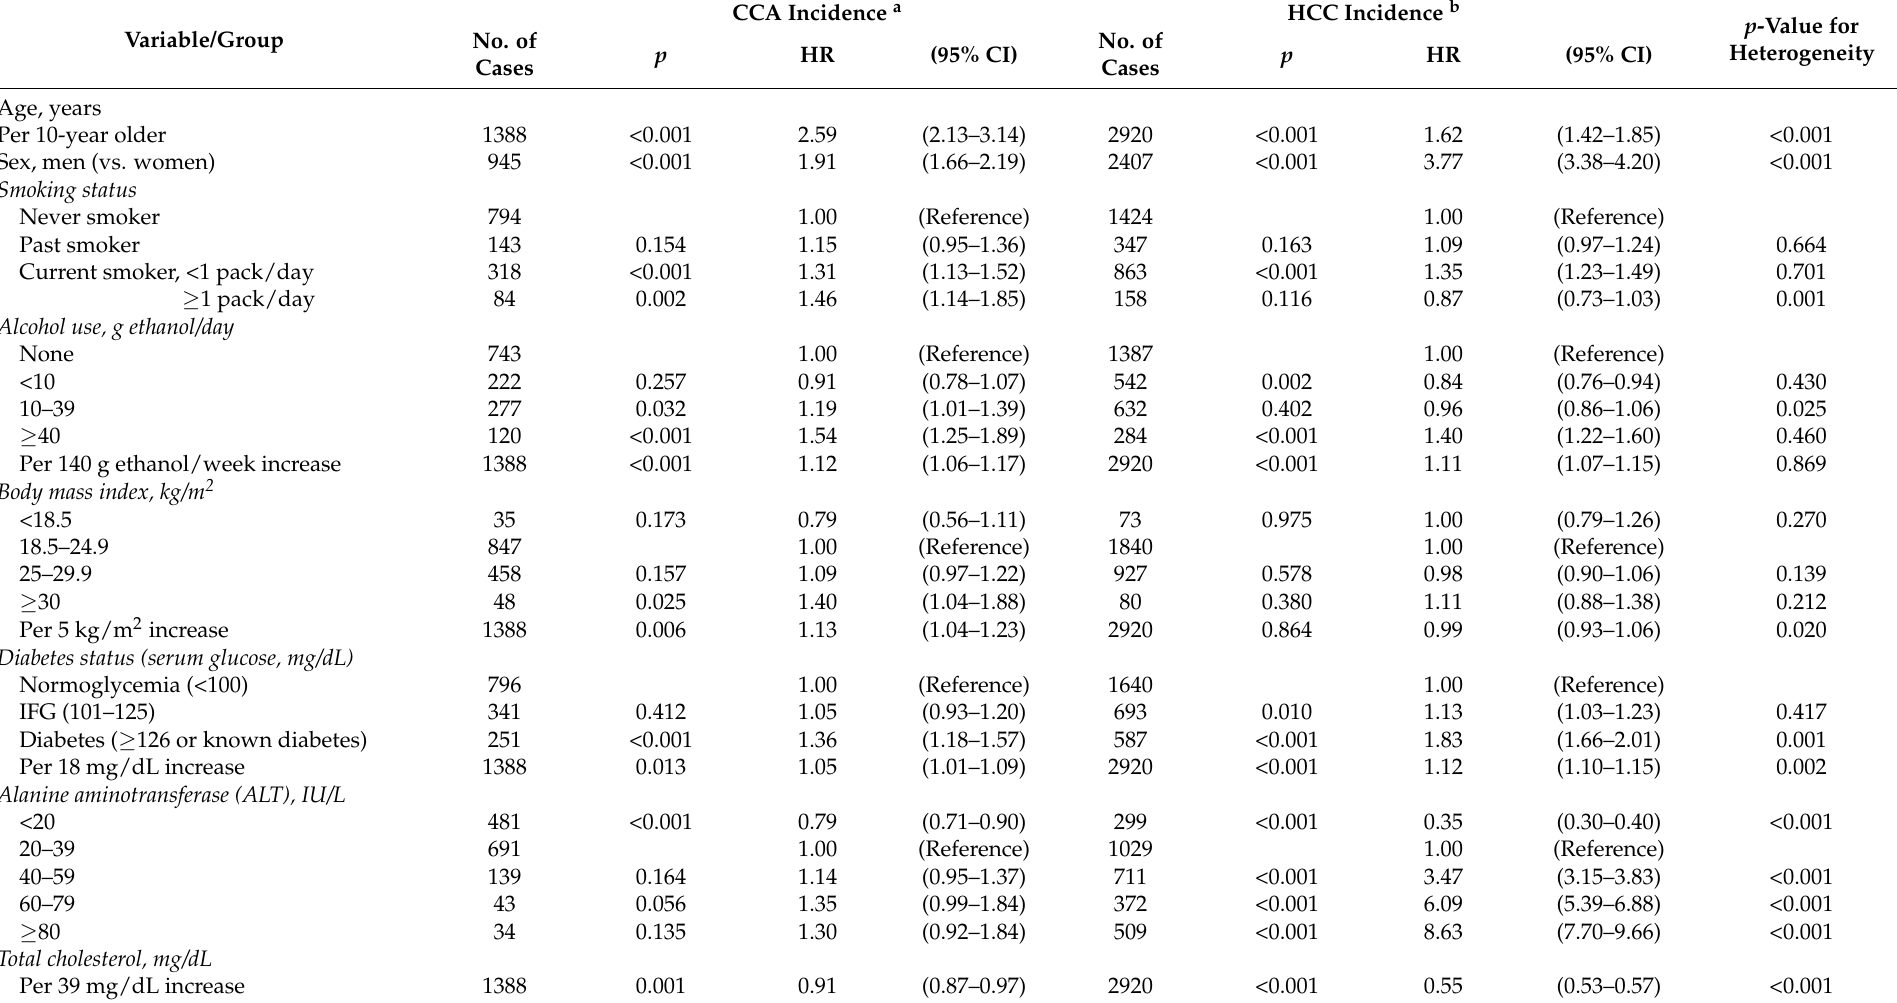
Table 2. Multivariable-adjusted HRs of CCA and